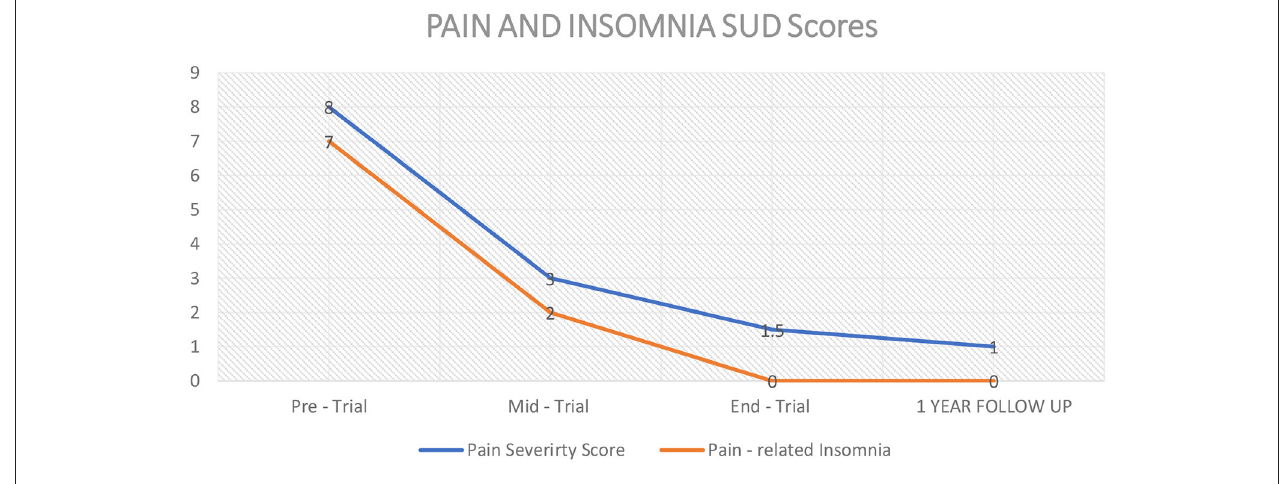
FIGURE 3 | Pre, mid, and post-trial pain intensity and pain—related insomnia.